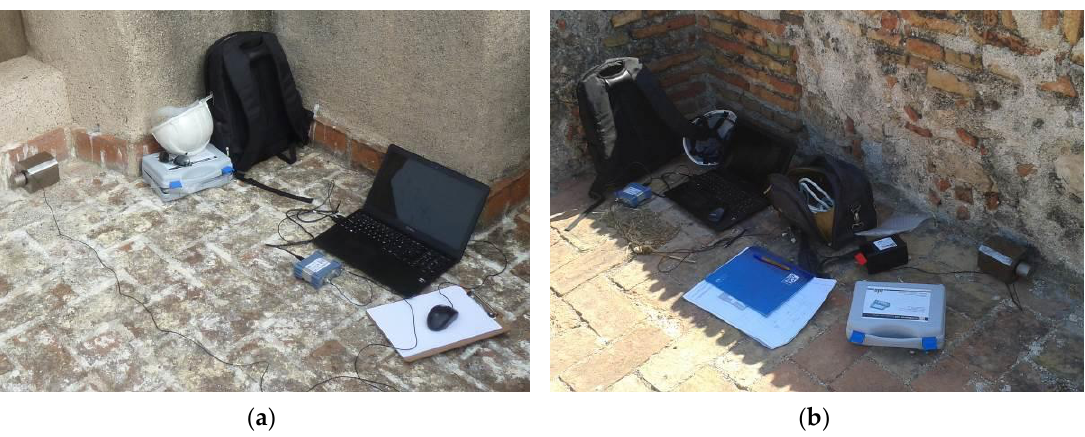
Figure 12. Ambient vibration tests at: ( a ) Duque tower (Marbella, Malaga), ( b ) Pimentel tower (Torremolinos, Malaga).